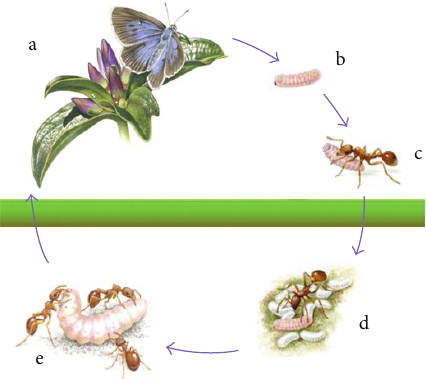
Figure 1: The Myrmica ants- Maculinea larvae system.